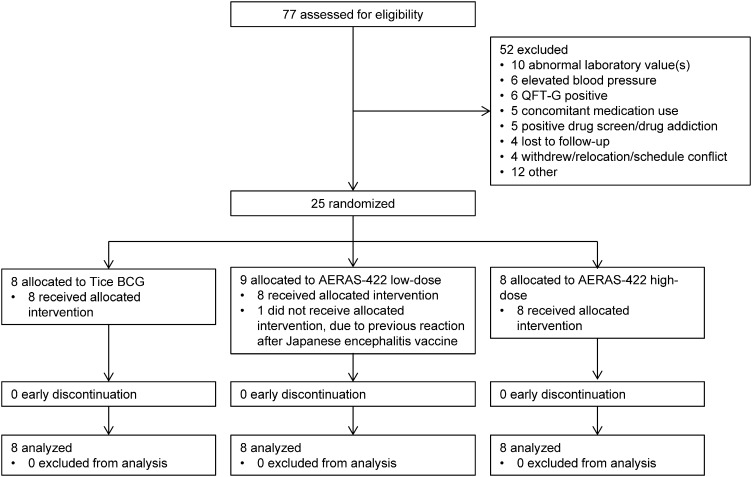
Consort Diagram.